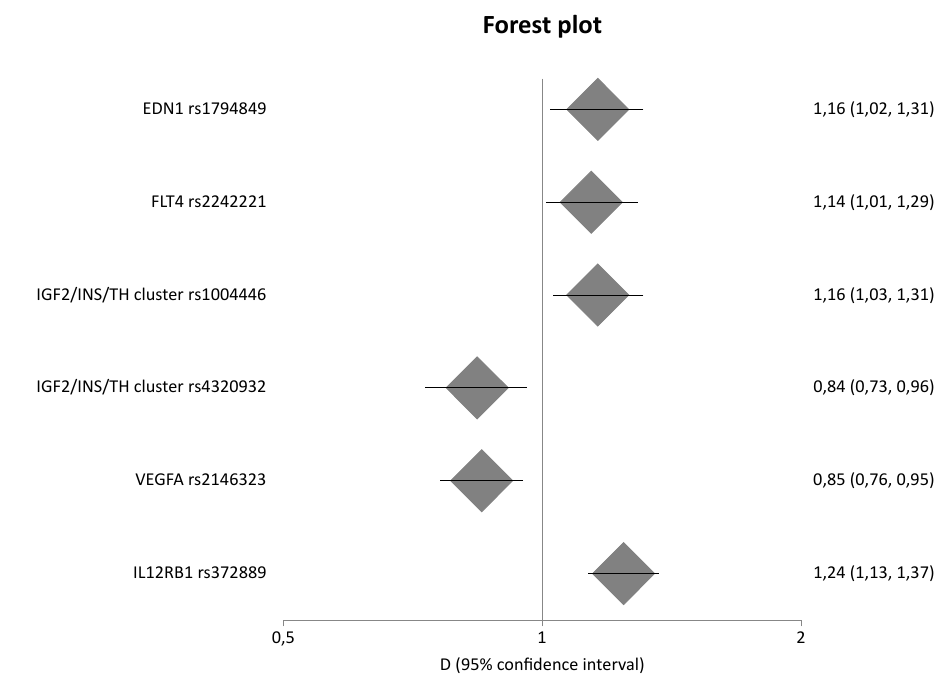
Figure 6. Meta-analysis results of diseased controls versus cases and healthy controls versus cases based on allele counts.